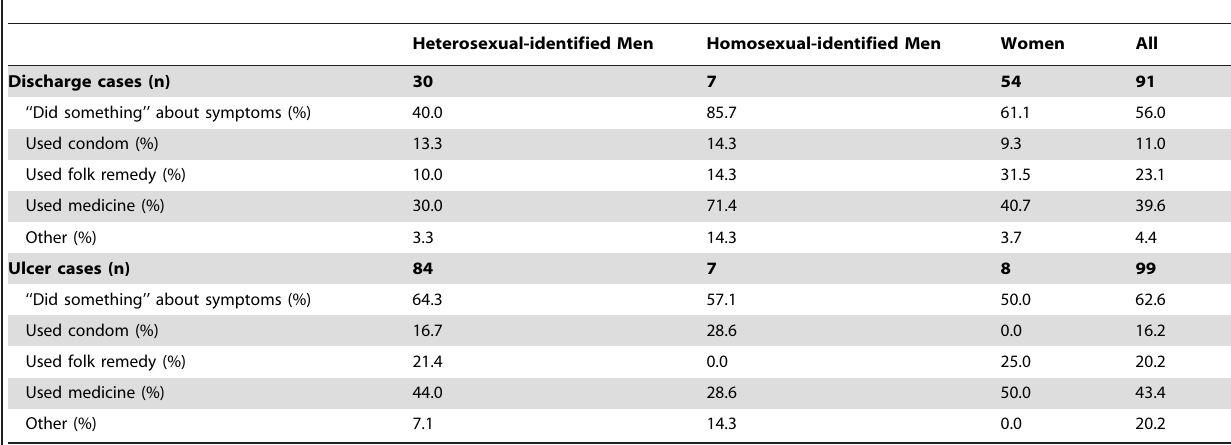
Table 3. Response to STI Symptoms (Participants with Ongoing Sexual Activity); Lima, Trujillo and Chiclayo, Peru